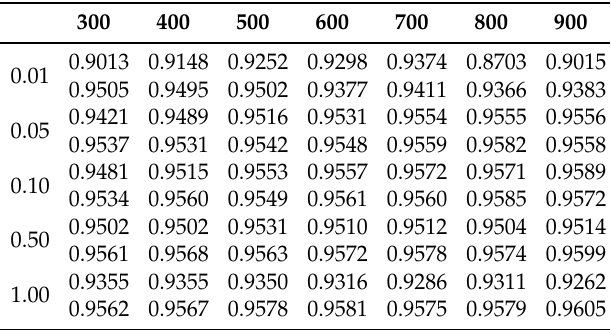
Table 6. OA on different values of sparsity and number of hidden nodes over Flevoland image by two classification networks based on AE and the proposed MAE.